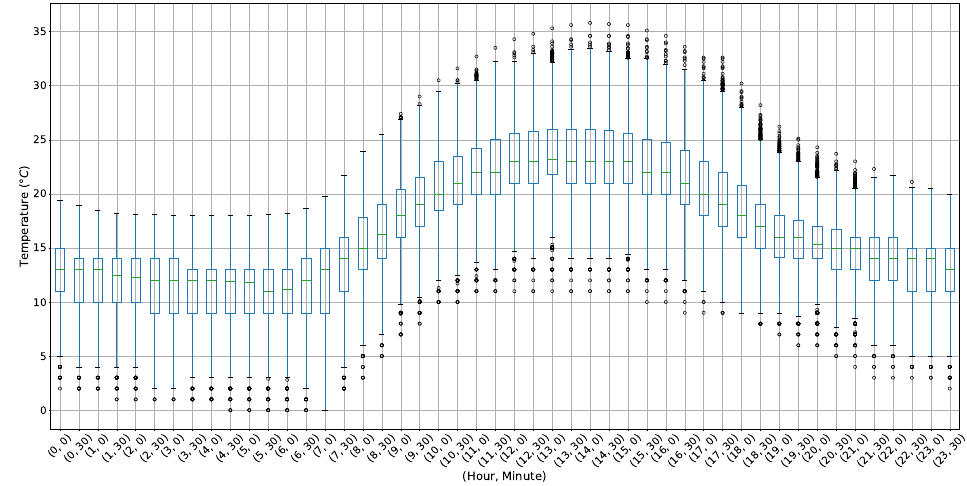
Figure 8. Boxplot of temperature for every intraday timestep from 2007 to 2019.